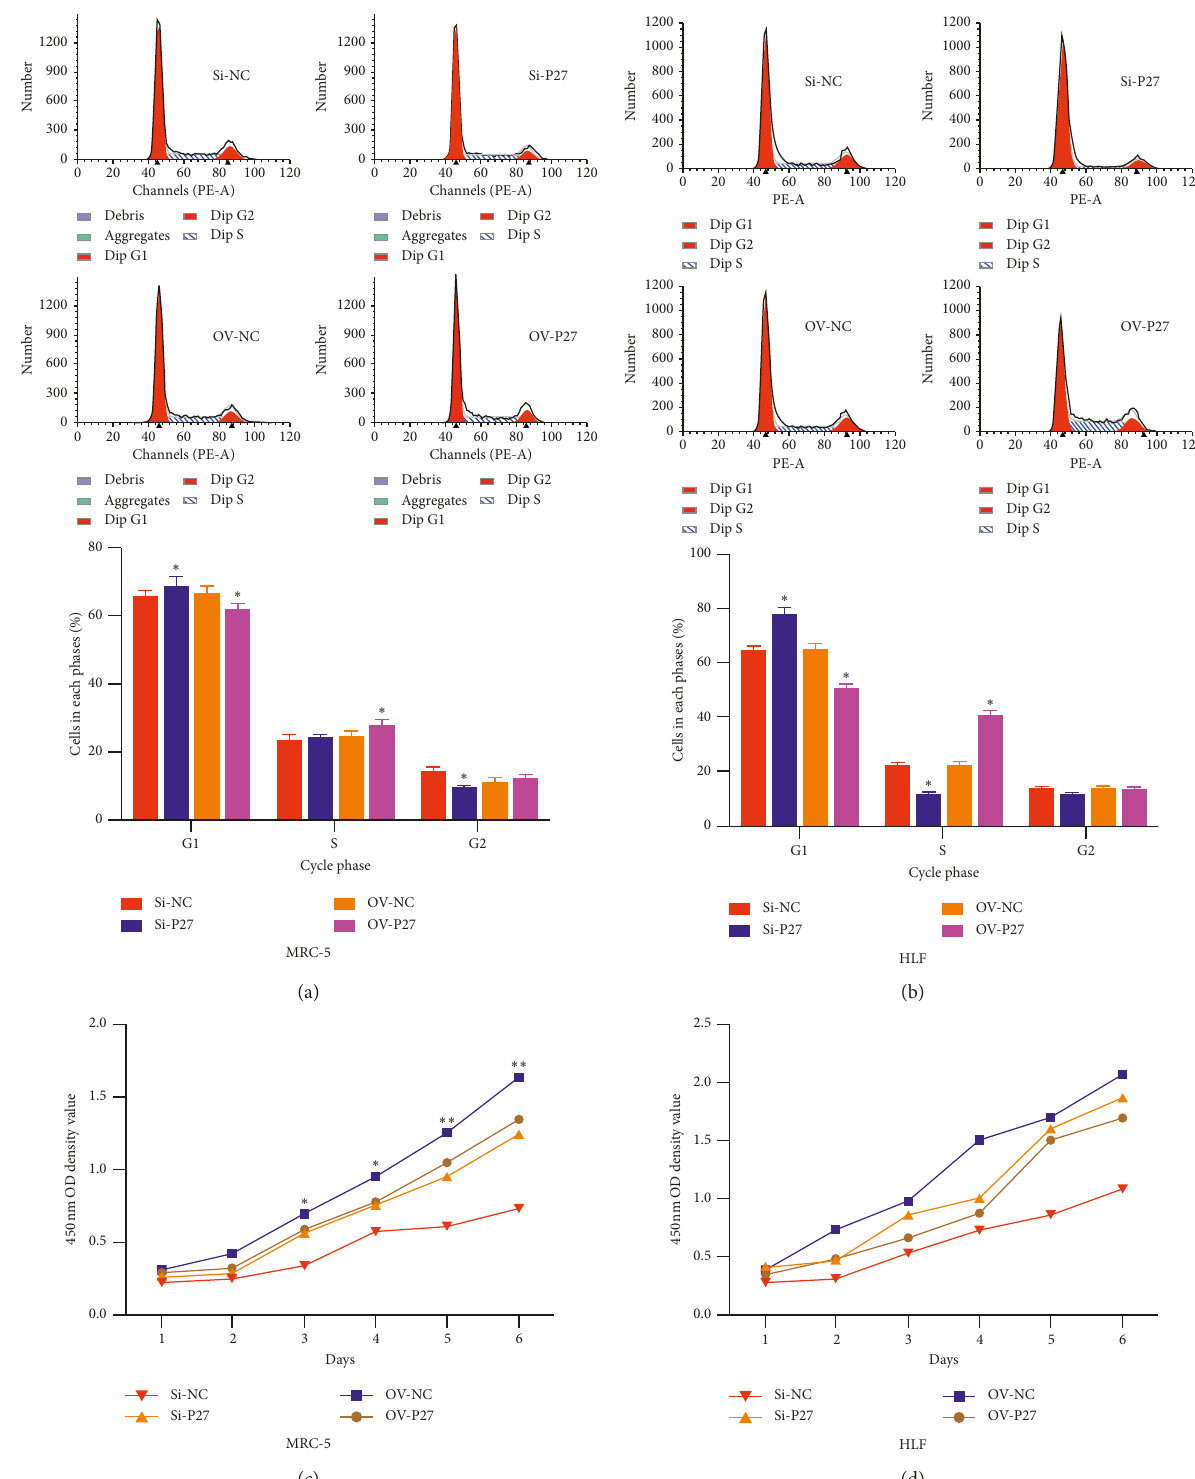
Figure 2: The role of P27 on the cell cycle of proliferation in MRC5 and HLF cells. (a, b) The role of P27 on the cell cycle by flow cytometry. (c, d) The role of P27 on the cell proliferation by CCK-8